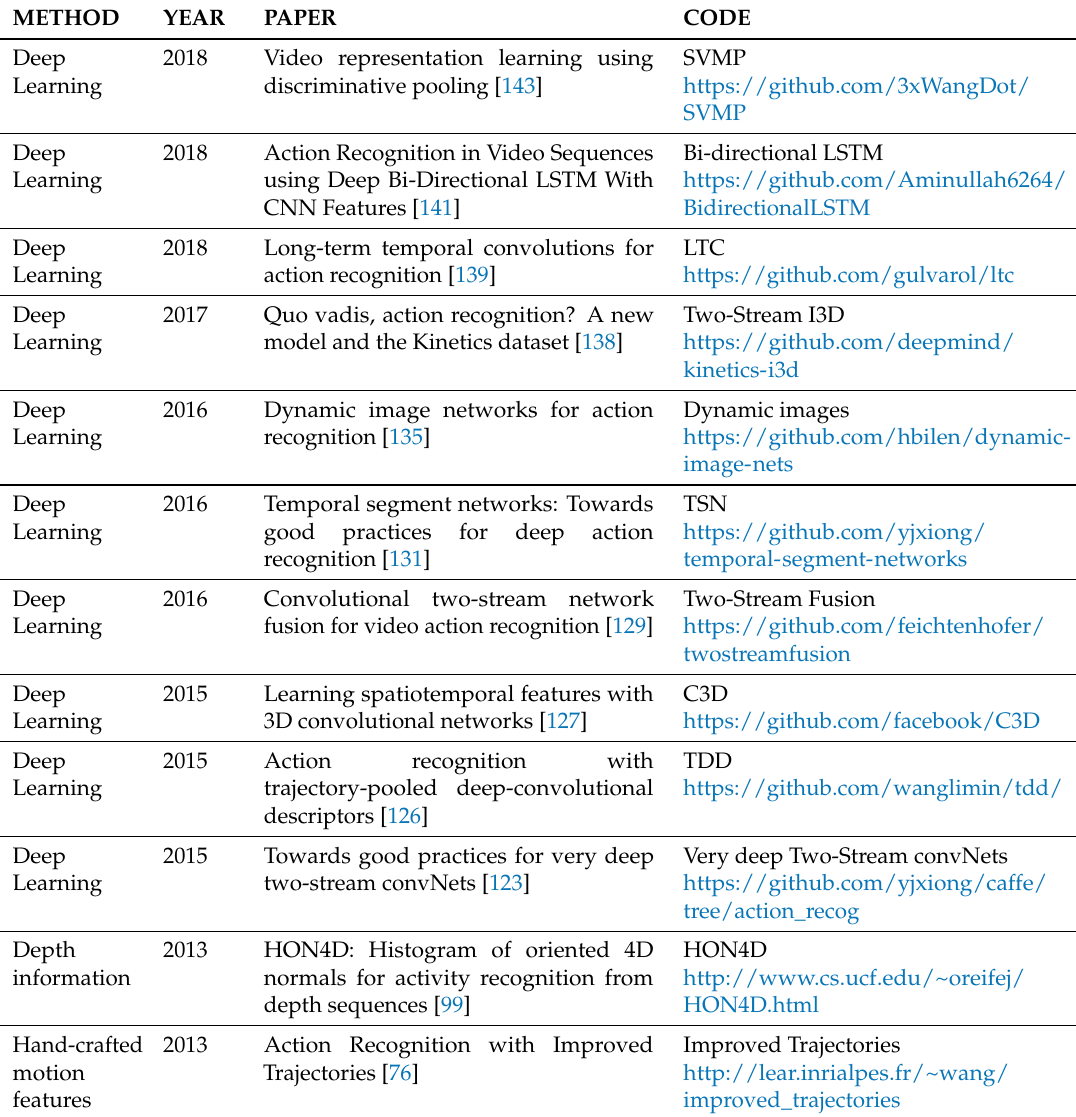
Table 8. Available code for presented